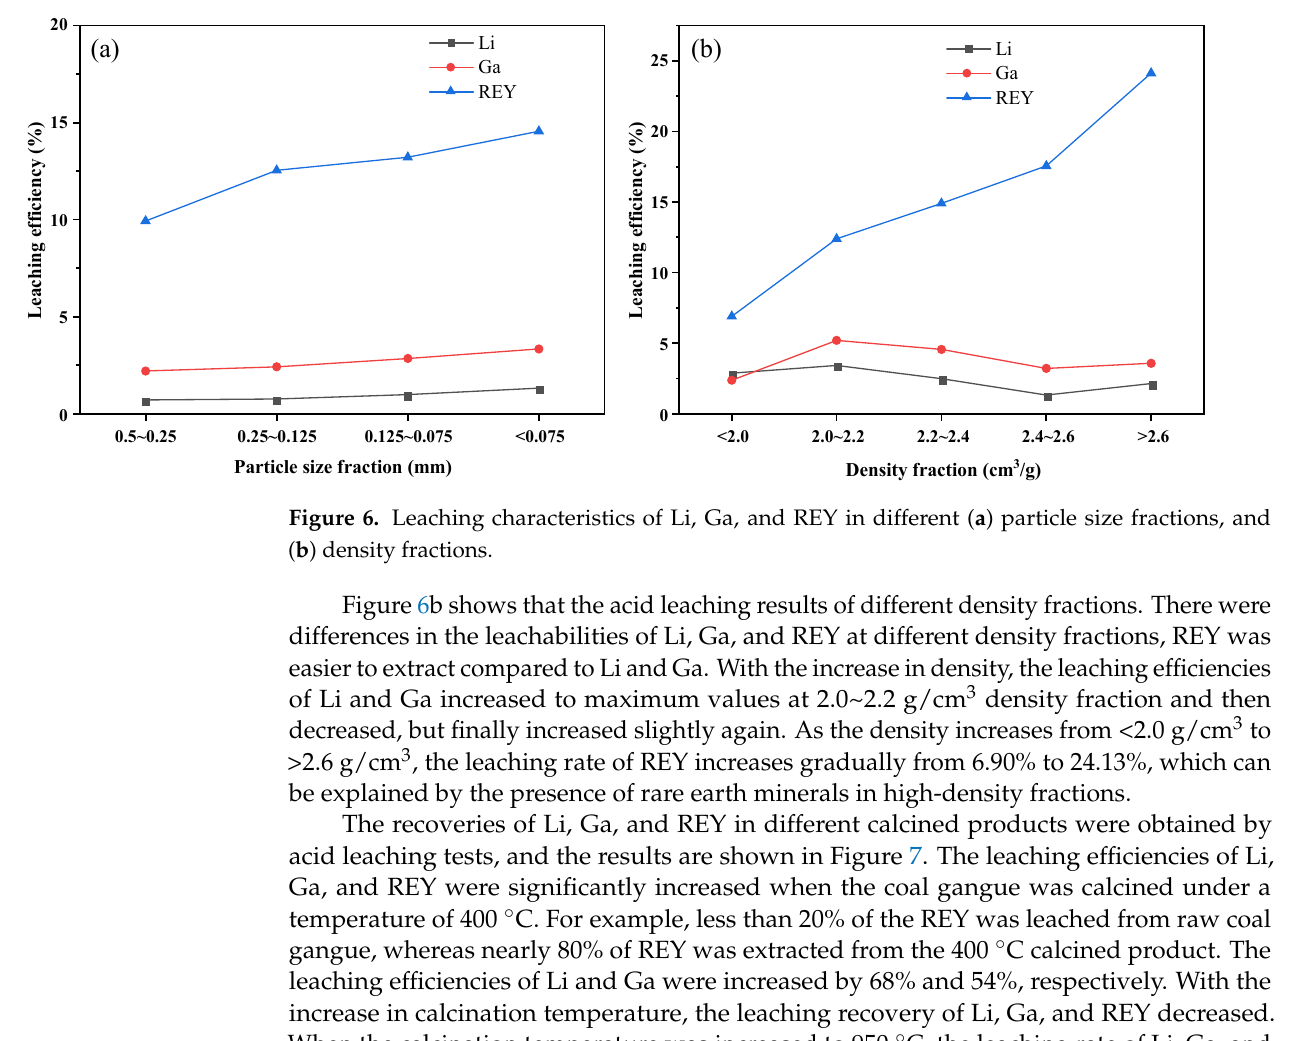
Figure 7. Effects of calcination on the recovery of Li, Ga, and REY from coal gangue. raw